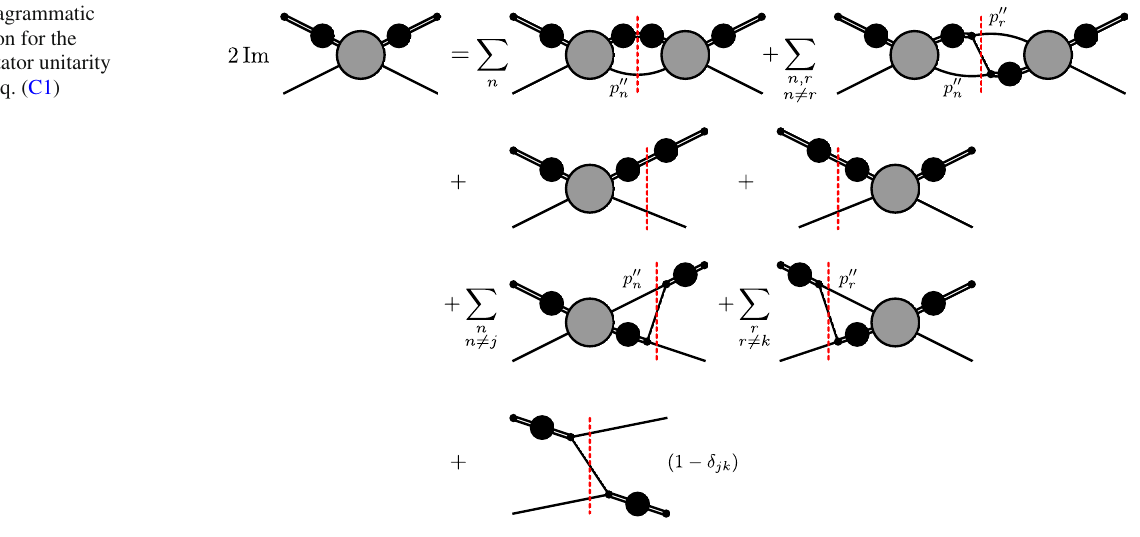
Fig. 18 Diagrammatic representation for the isobar–spectator unitarity relation in Eq.